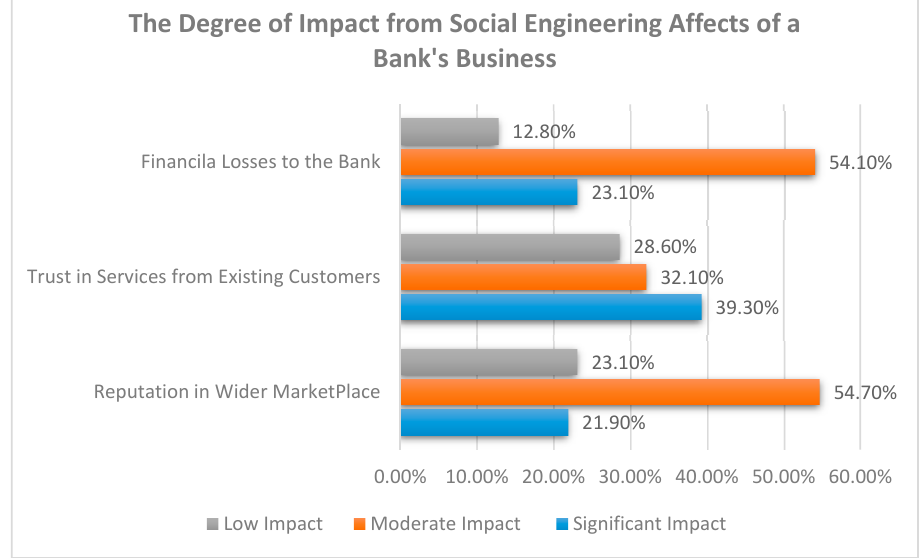
Figure 6. Global impact of social engineering attacks on key banking operations (Data from [32]).